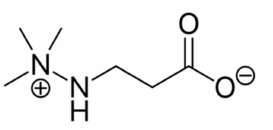
Figure 6. Chemical structure of